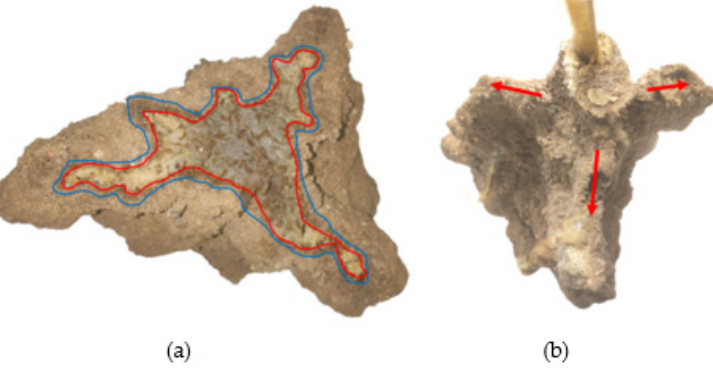
Figure 13. Test 6 chemical grouted sands: ( a ) sectional view; ( b ) top view.